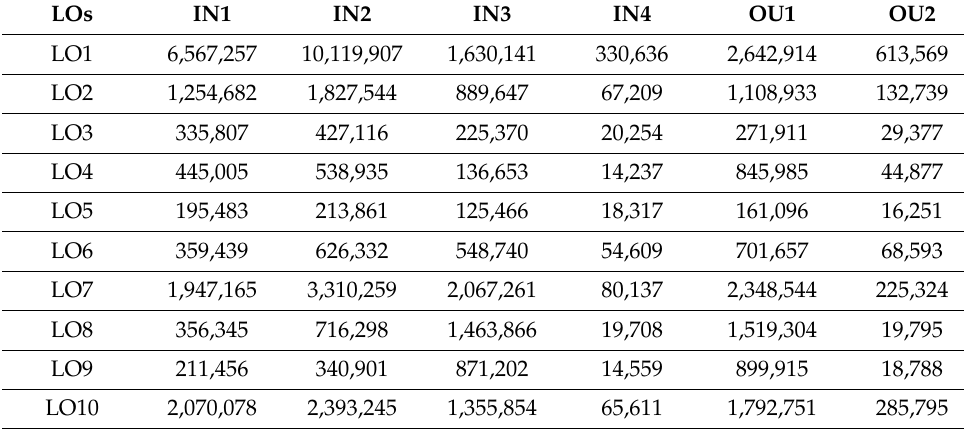
Table 4. Data of 10 LOs in 2019 (Statistics